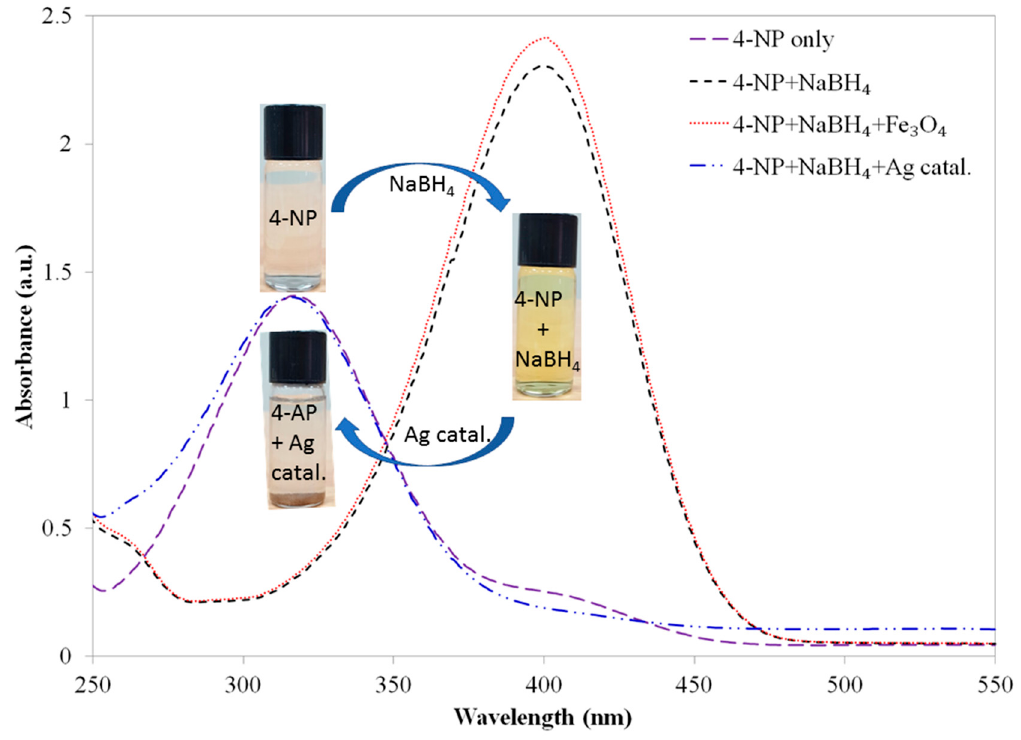
Figure 7. Optimization of catalytic reduction of 4-NP to 4-AP monitored by UV-Vis spectra of 4-NP only ( violet line), in presence of NaBH 4 ( black line), NaBH 4 with Fe 3 O 4 ( red line) and NaBH 4 with 1.5 mg (1.2 × 10 − 6 mol Ag) of catalyst Fe 3 O 4 @CS@MS@Ag ( blue line).